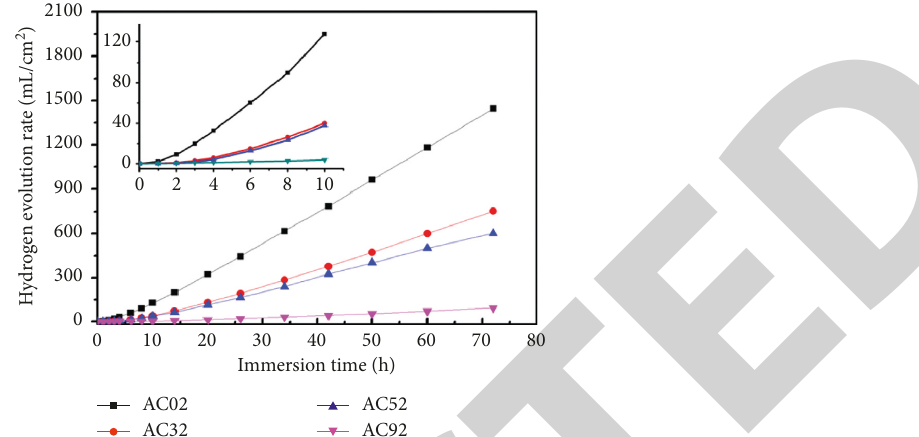
Figure 3: Relationship between hydrogen evolution rate and immersion time of the as-cast ACx2 alloy immersed in 3.5% NaCl solution for 72h.